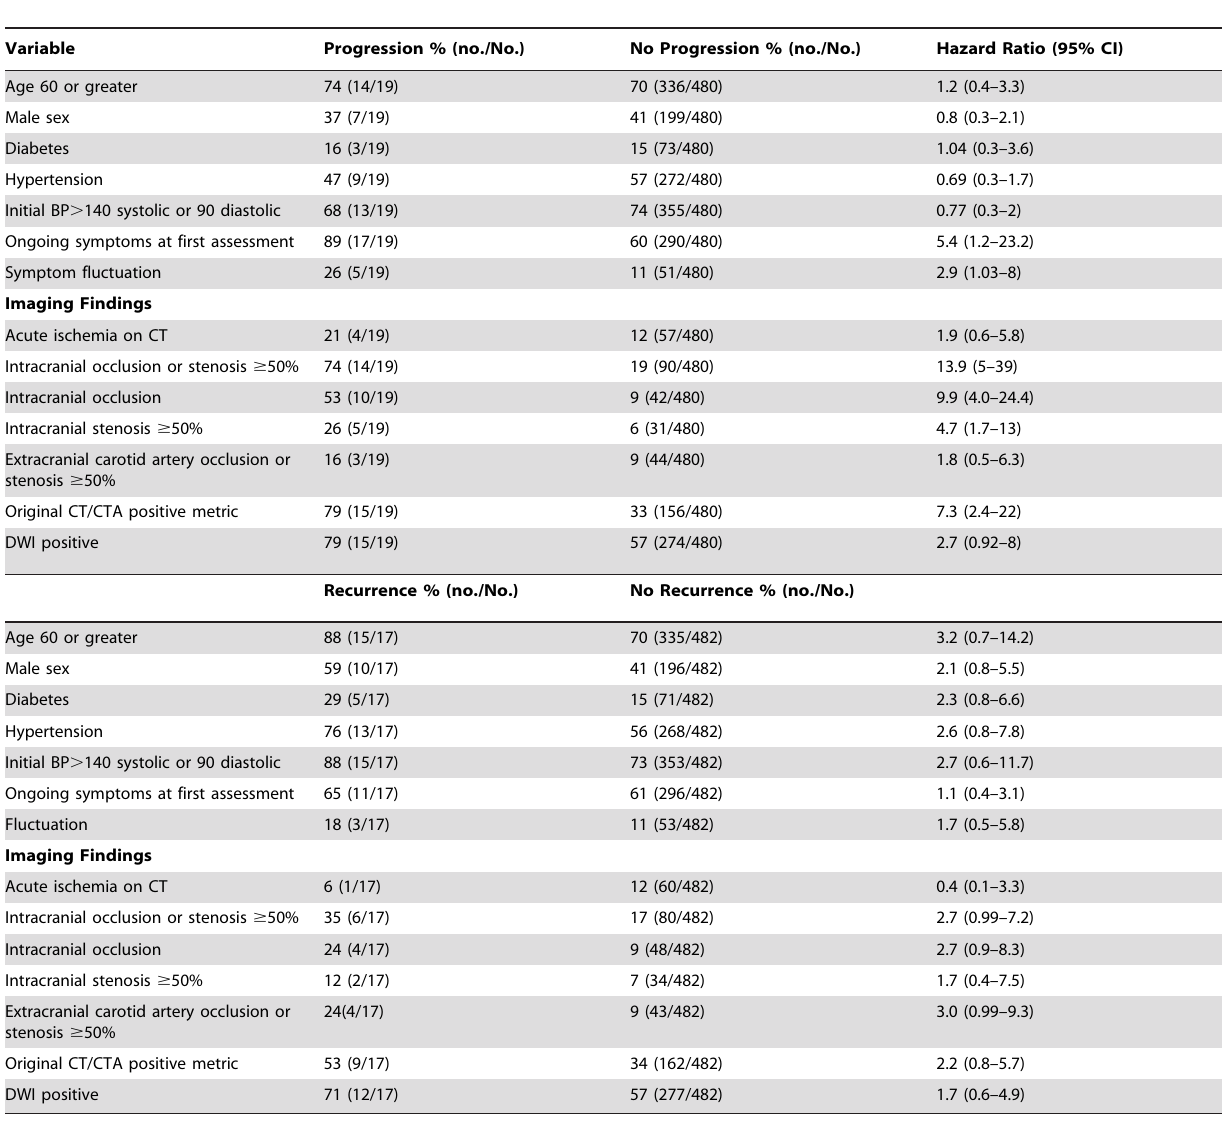
Table 3. Effect of clinical and imaging parameters on symptom progression (persistent worsening of symptoms related to the presenting event) and recurrent stroke (persistent new or worsening symptoms caused by something other than the presenting